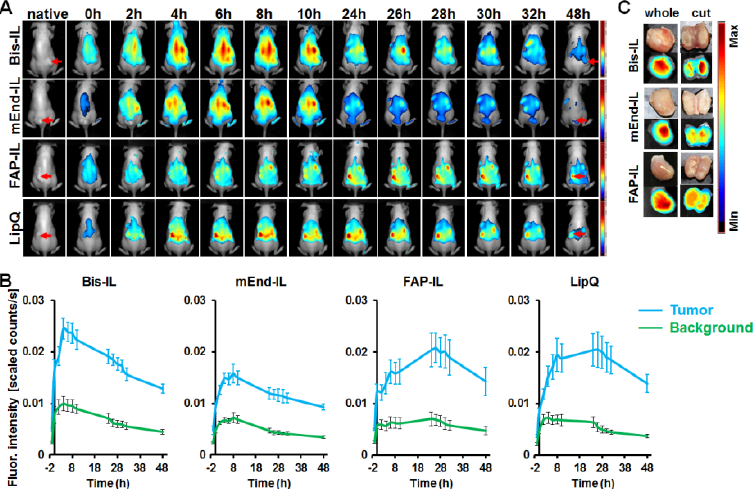
Figure 6. In vivo NIRF imaging of MDA-MB231 xenografts with activatable liposomes. ( A ) Representative NIRF images of mice imaged over 48 h post injection of 20 µ mol (final lipids) / Kg body weight of the indicated liposomes. Images per liposomal probe were compared with one another using the Maestro 3.0 software. Color-coded fluorescence: strong (red)-weak (blue). Red arrows depict the tumor. ( B ) Representative plots of the semi-quantitative levels of the tumor fluorescence intensities after unmixing the background fluorescence. Each line depicts the mean of n = 7 (Bi-FAP / mEnd-IL), n = 7 (mEnd-IL), n = 5 (FAP-IL), n = 6 (LipQ) and the respective standard error, SEM. ( C ) Representative NIRF images of tumors excised from the mice 48 h post injection reveal retention of the liposomes.